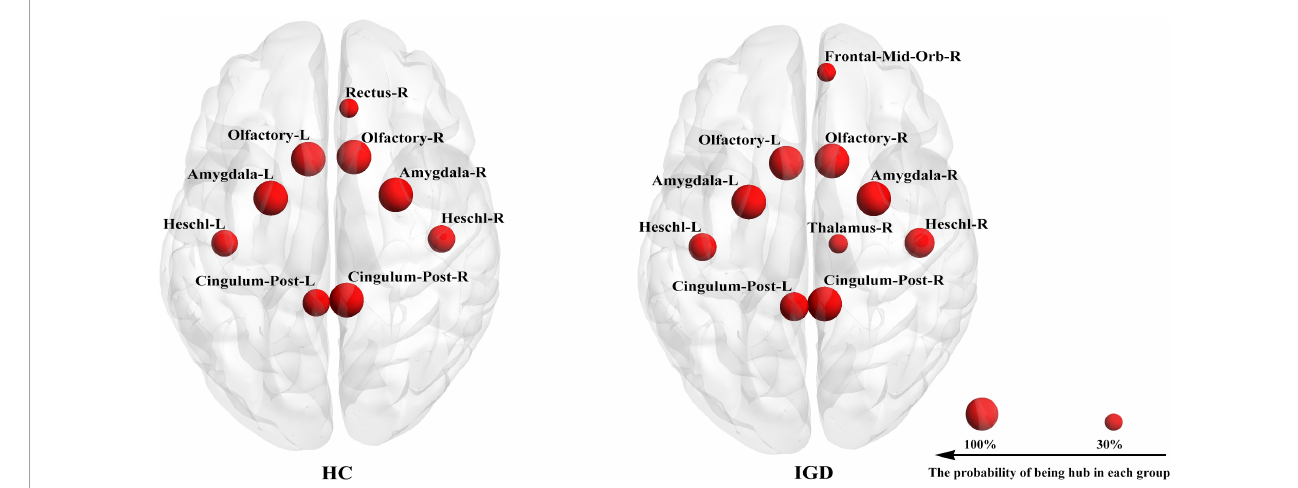
FIGURE3 Each group has its own hub distribution. It showed the hub with a probability of being a hub greater than 30%.